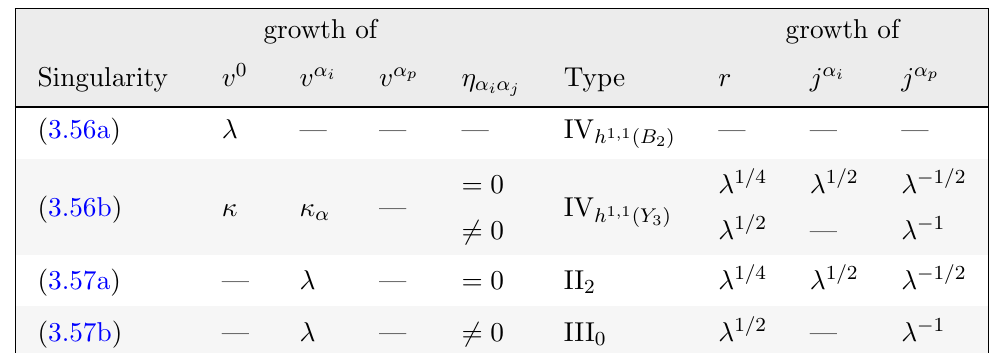
Table 4 . Large volume singularities in terms of the F-theory coordinates r and j ’s. We collectively denoted v α i , i = 1 , . . . , n the coordinates that are taken in the limit and v α p , p = n +1 , . . . , h 1 , 1 ( B 2 ) those that are not. In the second line, we defined λ = κ α /κ and assumed λ result is the same as the one of the first